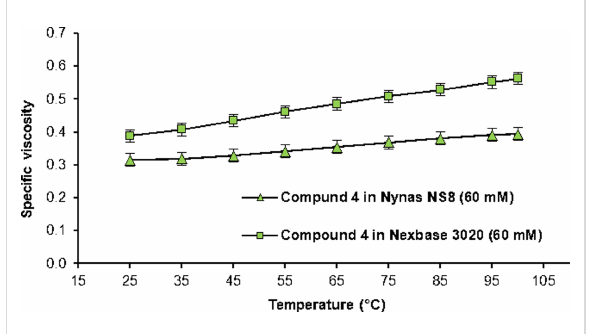
Thus, we focused our investigation on compound 4 , which seems to possess the correct distance between the BINAM core and the ACP binding unit for the RVT effect, while being sig- nificantly more soluble than compound 2 due to the additional hexyl substituents. This allowed its use in Nexbase 3020 (at 60 mM concentration) in a final application test. As shown in Figure 8, the specific viscosity in Nexbase 3020 is not